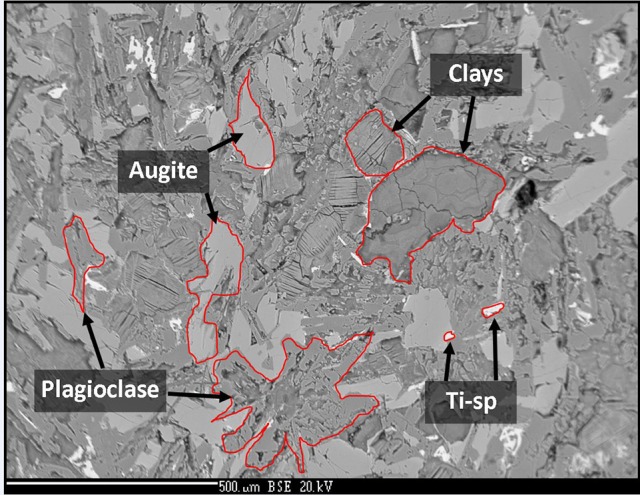
Back-scatter electron image of the analog basalt used in this experiment. Augite, plagioclase, clay, and Ti-spinel are observed. Image width is ~1.5 mm.